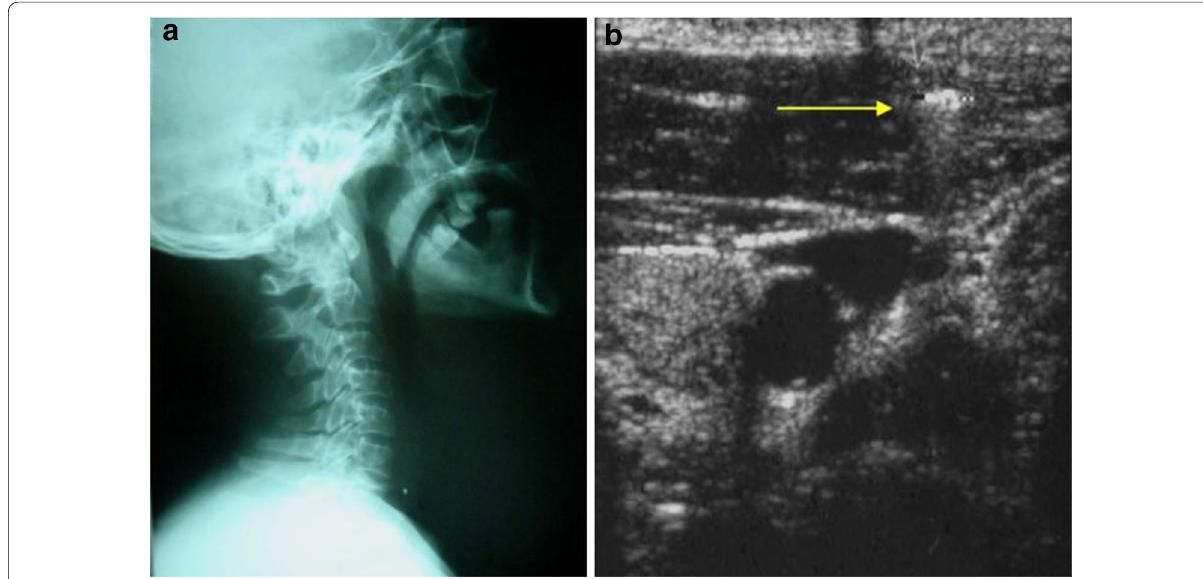
Fig. 2 No vascular compromise: B mode. a X ray showing a bullit in the base of the neck. b Mode showing the bullit in the esternocleidomastoid muscle. No vascular compromise of the jugular vein nor the carotid artery